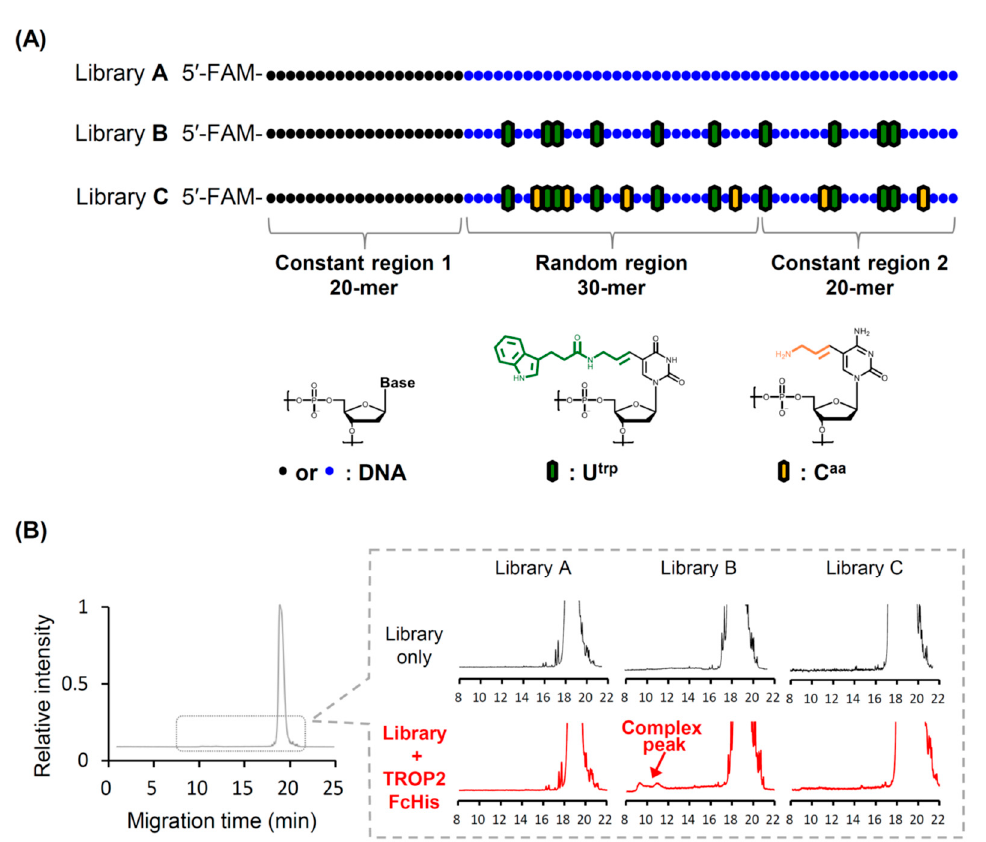
Figure 1. Pre-screening of artificial nucleic acid libraries using CE. ( A ) Schematic representation of three random DNA libraries with different modifications. Each library contained a 30-mer random region flanked by two constant regions at the 5 ′ and 3 ′ ends. ( B ) Capillary electropherograms for each library with or without human TROP2 FcHis protein are shown in the pre-screening experiment. All electropherograms recorded the fluorescent intensity of FAM-labeled aptamers versus migration time (min), and extremely small, complex peaks were detected by zooming into the relevant peak areas.